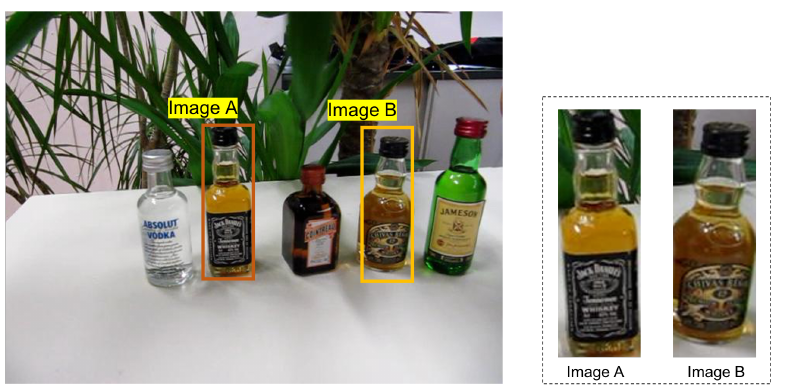
Figure 2. Images A and B are templates with the size 195 ×